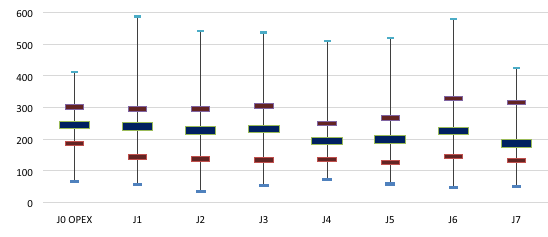
Fig. 1 7‑day evolution in PaO 2 /FiO 2